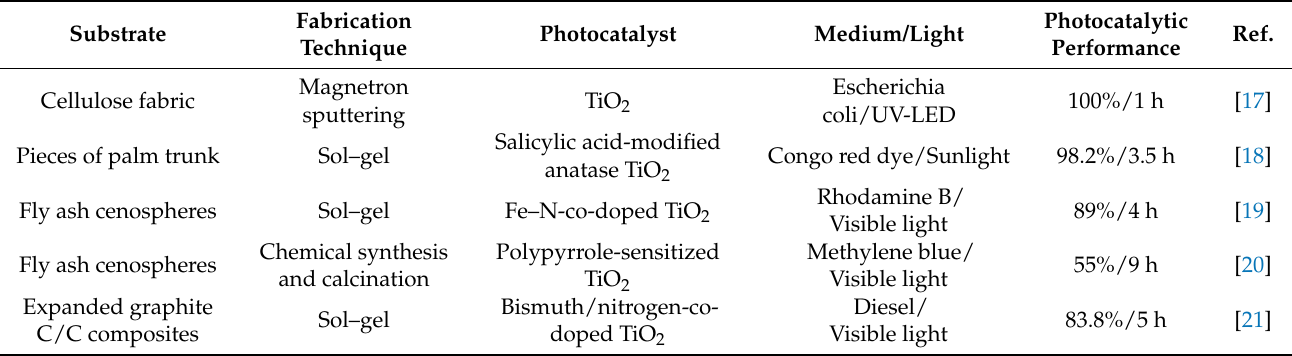
Table 1. Review of recent studies of floating TiO 2 -based photocatalyst application for the photocatalytic treatment of various